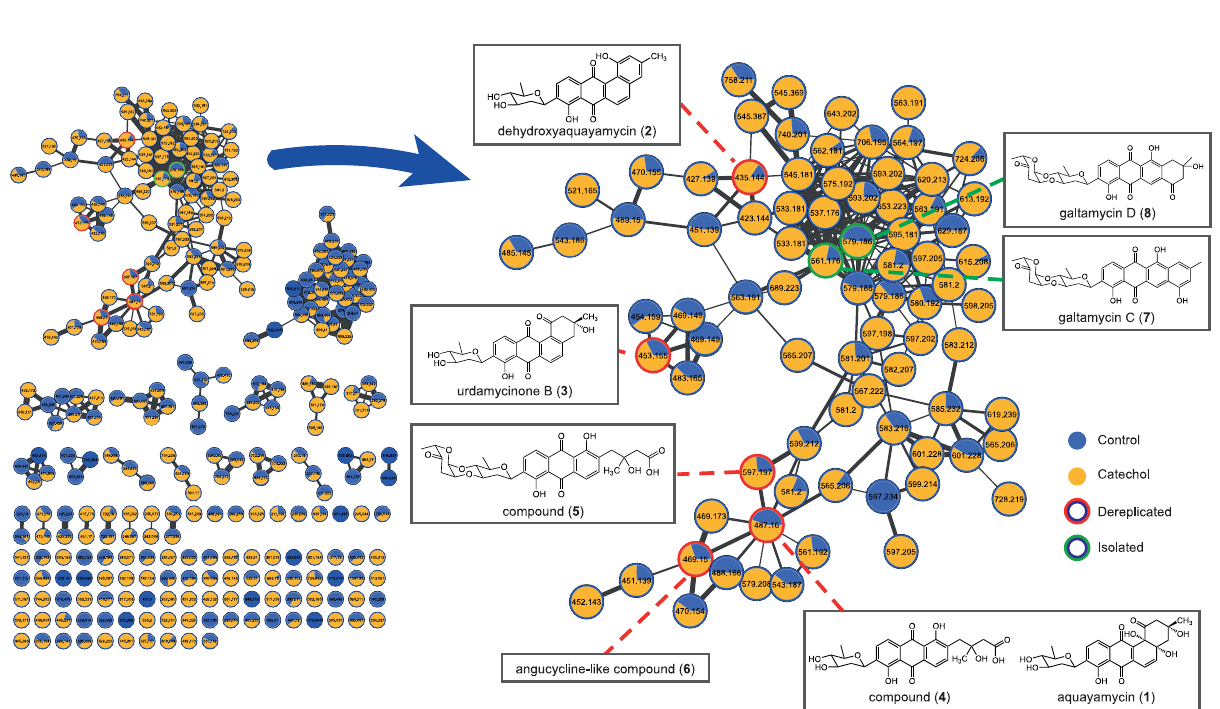
Fig. 3 Catechol elicits the bioactivity and metabolite production of Streptomyces sp. MBT84. a The antibacterial activity against B. subtilis 168 and yellow pigment production of Streptomyces sp. MBT84 are increased in the presence of catechol. b None of the structurally related compounds, including epinephrine, increased the antibiotic production by Streptomyces sp. MBT84. One-way ANOVA, followed by a post hoc Tukey ’ s HSD test, was performed to compare the difference in bioactivity between the growth conditions (* p < 0.001, n = 3, mean and standard deviation are indicated in red, the grey box highlights the response to compounds with a catechol moiety). c LC-MS chromatogram overlay of the crude extract of Streptomyces sp. MBT84 grown with and without catechol. Multiple peaks were increased in intensity in the presence of catechol. d Volcano plot highlighting the increased metabolite production by Streptomyces sp. MBT84 in response to catechol. The x and y axes represent the log 2 fold changes and the corresponding − log 10 FDR- adjusted p -value of all the mass features, respectively. Red circles represent the mass features in catechol-grown cultures with a signi fi cant intensity difference of more than twofold compared to control cultures (FDR-adjusted p ≤ 0.1). Circles situated in the top left and top right quadrants represent the mass features that are most induced or repressed, respectively, by catechol with high statistical signi fi cance. The m/z values 469.149 and 579.186 are shown in purple and green, respectively ( n